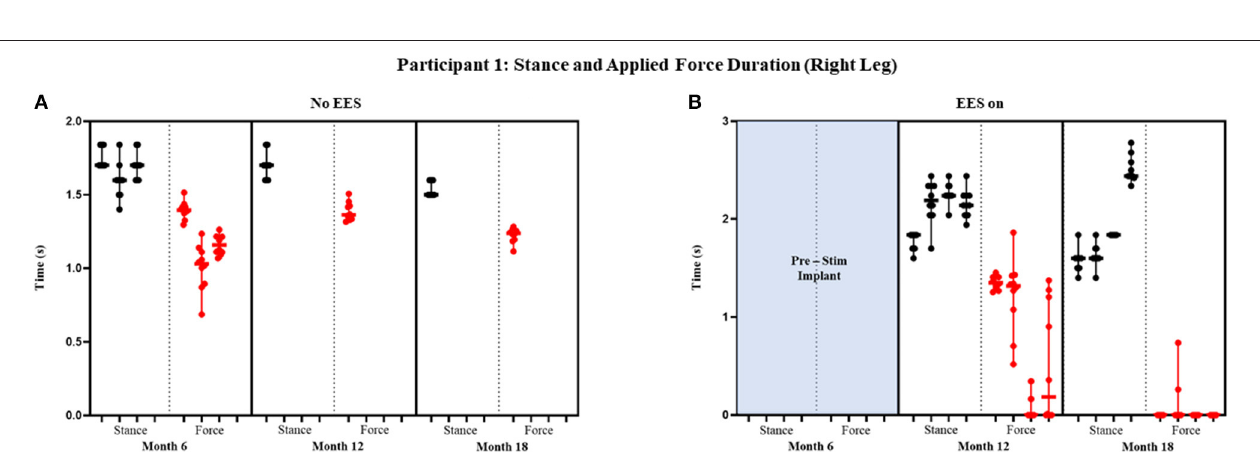
Frontiers in Rehabilitation Sciences |